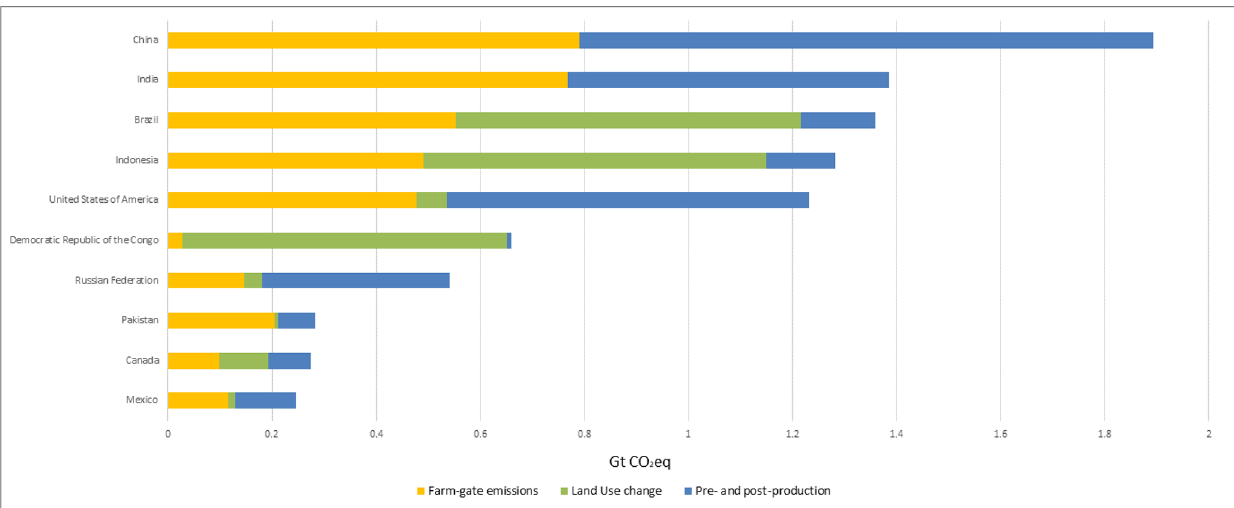
Figure 5. Total GHG emission from agri-food systems by country, top 10 emitters, 2019. Color bars show contributions by emissions within the farm gate (yellow), land use change (green), and pre- and post-production along food supply chains (blue). Source: FAOSTAT (FAO, 2021a).